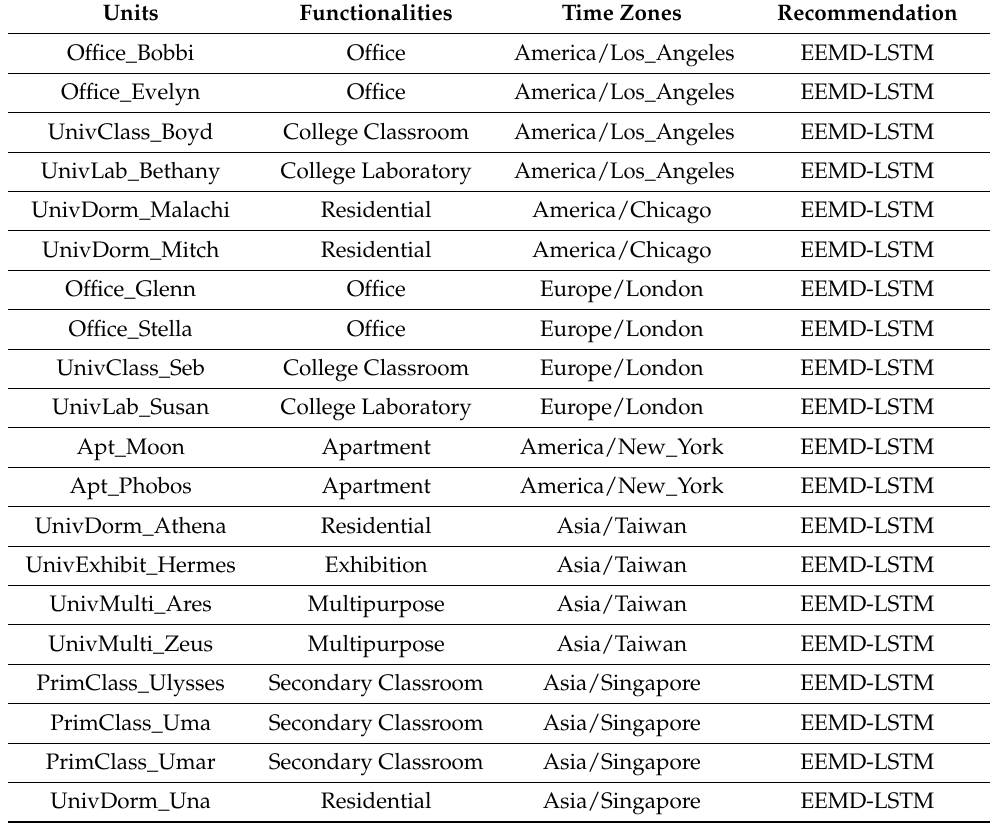
Table 18. Recommendation of the forecasting method. Units